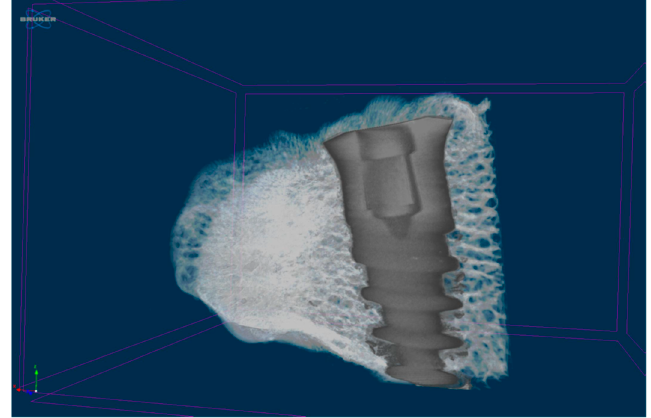
Figure 3. Dental implant implanted in the fresh cow rib. Image of micro CT.